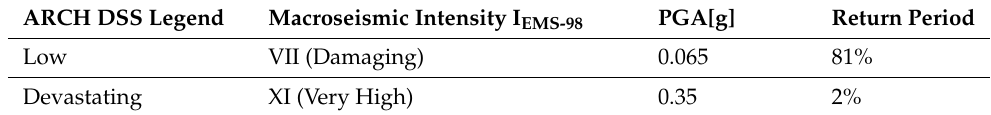
Table 7. ARCH DSS Camerino, hazard scenarios.